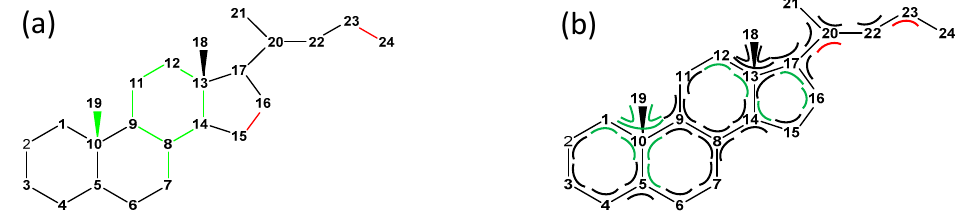
Figure 6. Standard steroid according to ( a ) the bond lengths and ( b ) bond angles and their respective standard deviations (see text). Table 5. Mean distances and standard deviations for the bond lengths of the steroids analyzed in this paper, and comparison with progesterone and the lateral chain of cholesterol.